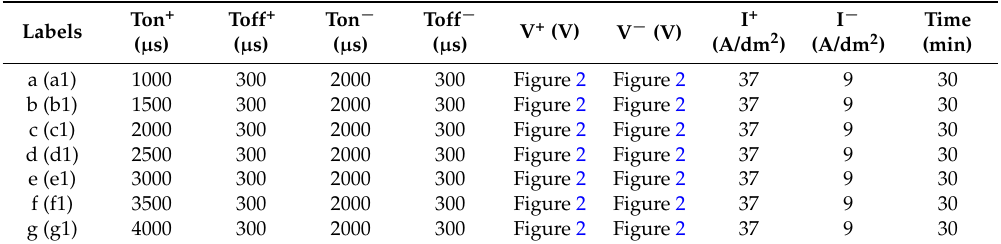
Figure 2. Variation curves of the voltage at different anode pulse-widths during microarc oxidation. ( I ) variation curves of anode and cathode voltages; ( II ) variation curves of anode voltages; ( III ) variation curves of cathode voltages; (a): 1000 μ s; (b): 1500 μ s; (c): 2000 μ s; (d): 2500 μ s; (e): 3000 μ s; (f): 3500 μ s; (g): 4000 μ s.